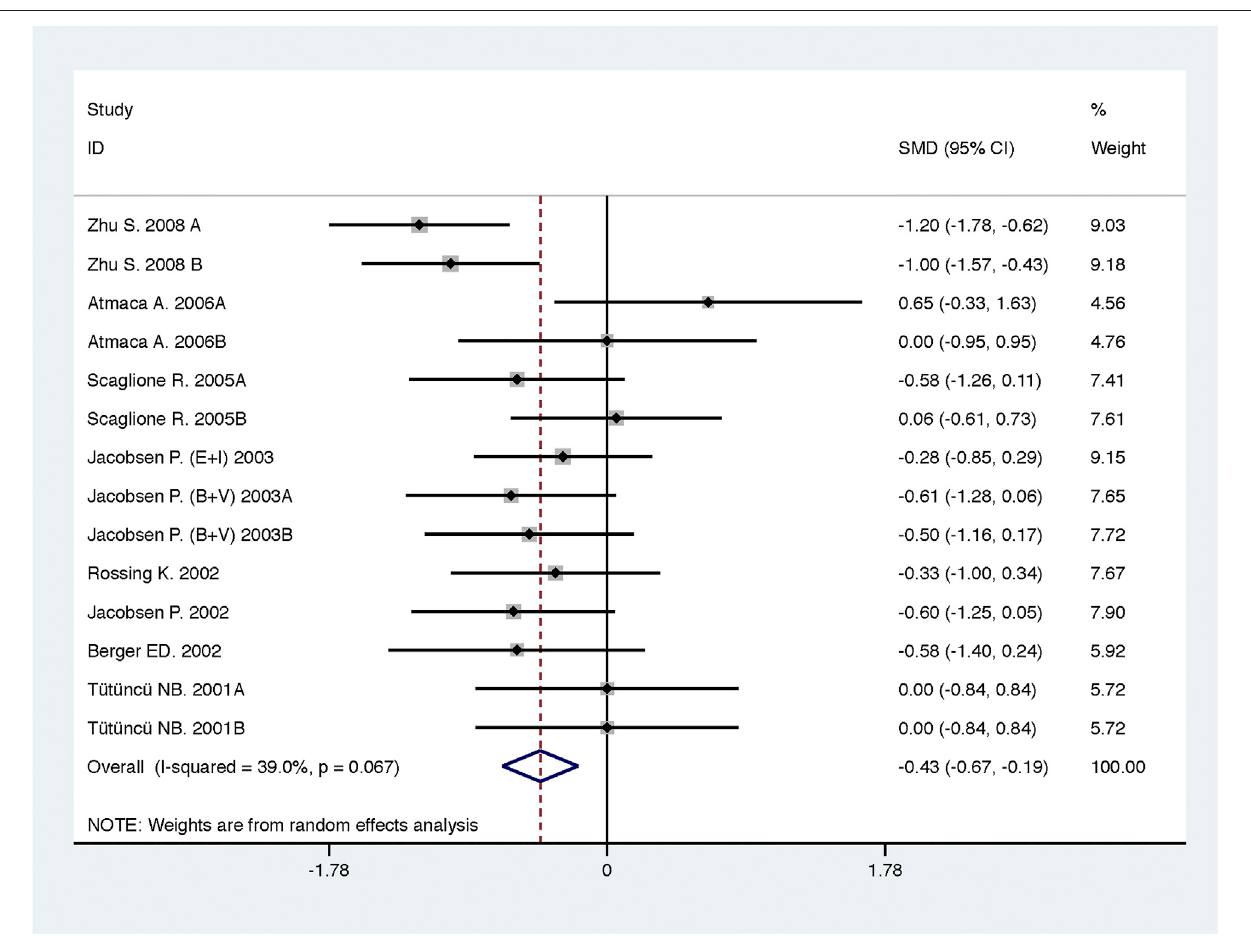
FIGURE 2 | Comparison of ACEI in combination with ARB vs. low-dose ACEI or ARB for urine albumin excretion (g/g of creatinine or g/24 h).